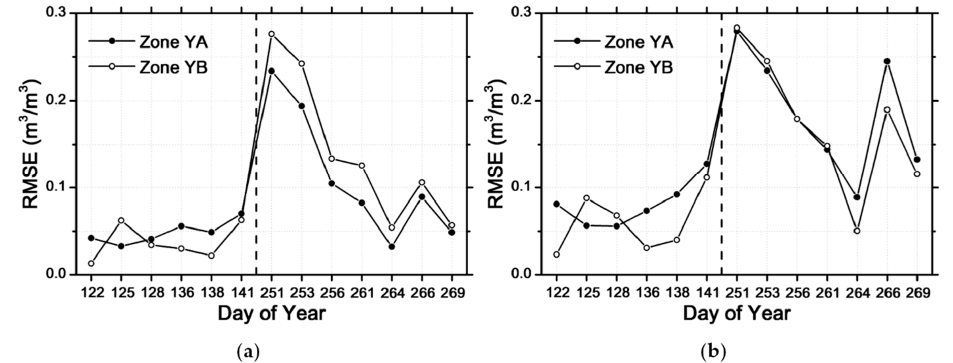
Figure 8. Error of NRSD and DISPATCH in different land covers. Zone YA represents the cropping area, and Zone YB represents the grazing area: ( a ) RMSE of NRSD and ( b ) DISPATCH. Please note the vertical dashed line distinguishes between the SMAPEx-4 and SMAPEx-5 periods.